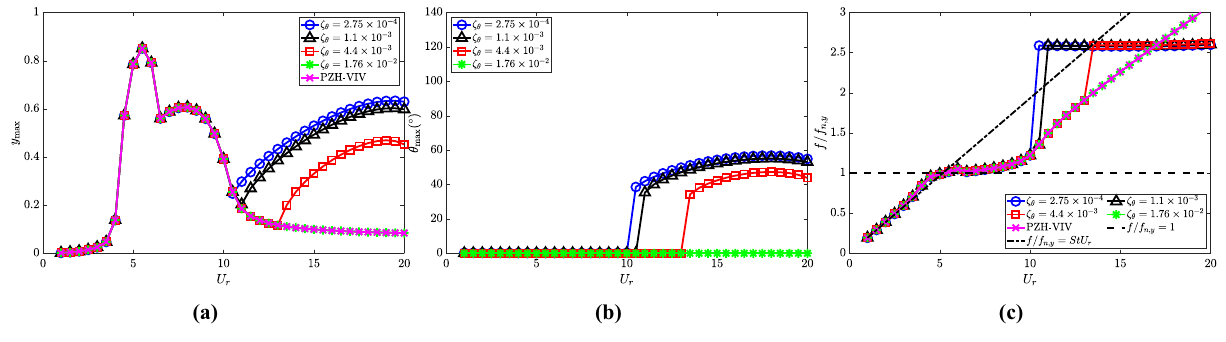
Figure 9. Response characteristics of the system for various ζ θ with U r : ( a ) maximum non-dimensional oscillation amplitude ( y max ) of the cylinder, ( b ) maximum angular rotation of the pendulum θ max in degrees ( ◦ ) and ( c ) dominant frequency with respect to cylinder natural frequency f / f n , y . Here, m = 0.3 , l d = 0.1 and ω r = 1.3 .